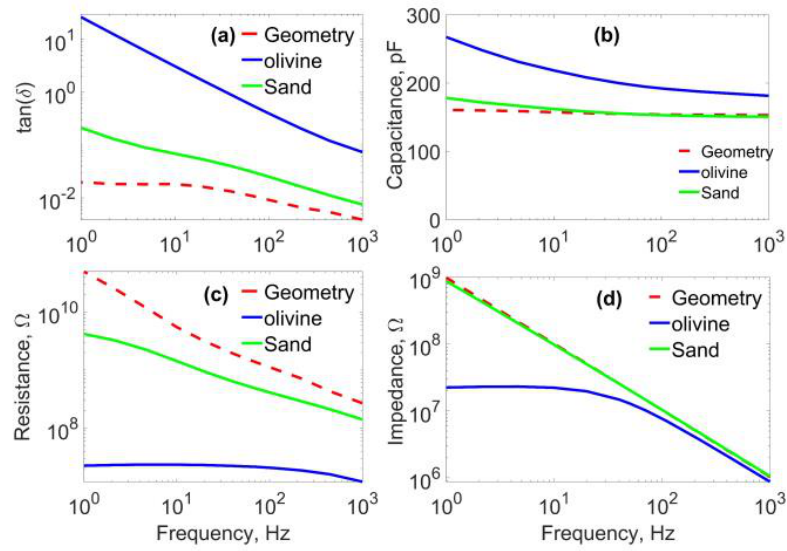
Figure 5. Surface parametric electrical properties of the chosen samples of the DBD bed materials measured at ambient temperature. ( a ) Loss factor; ( b ) capacitance; ( c ) resistance; ( d ) impedance. Table 1. Surface electrical properties of the DBD bed materials measured at frequencies from 1 Hz to 10 3 Hz.